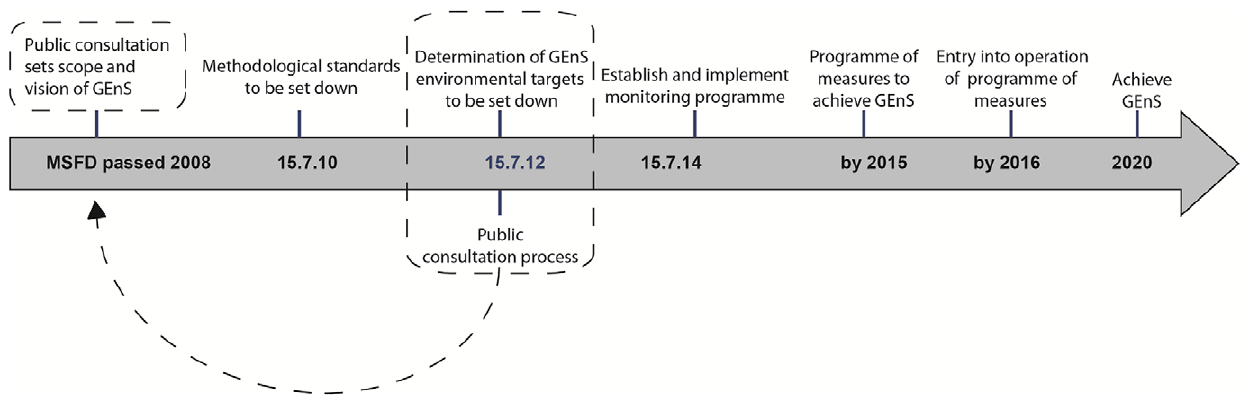
Figure 3. Timeline for the Marine Strategy Framework Directive. The timeline of implementation is established for all EU member states within the MSFD. If an ecosystem-based approach had been adopted from when the directive passed in to law in 2008, then the proposed public consultation i.e. stakeholder engagement, would have been applied in 2008 instead of the current plan to commence this process in 2012. The dotted box and arrow reflects the move of public consultation to